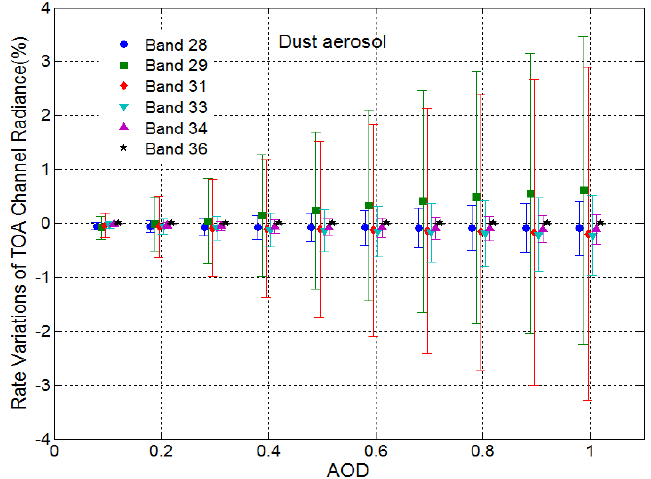
Figure 4. Comparing with the clear sky, the rate variations of top of the atmosphere (TOA) channel radiance at different aerosol conditions as the AOD increase. The symbols indicate the rate variations of channel radiance and the half-length of vertical bars represent the Standard Deviations of the rate variations of TOA channel radiance.